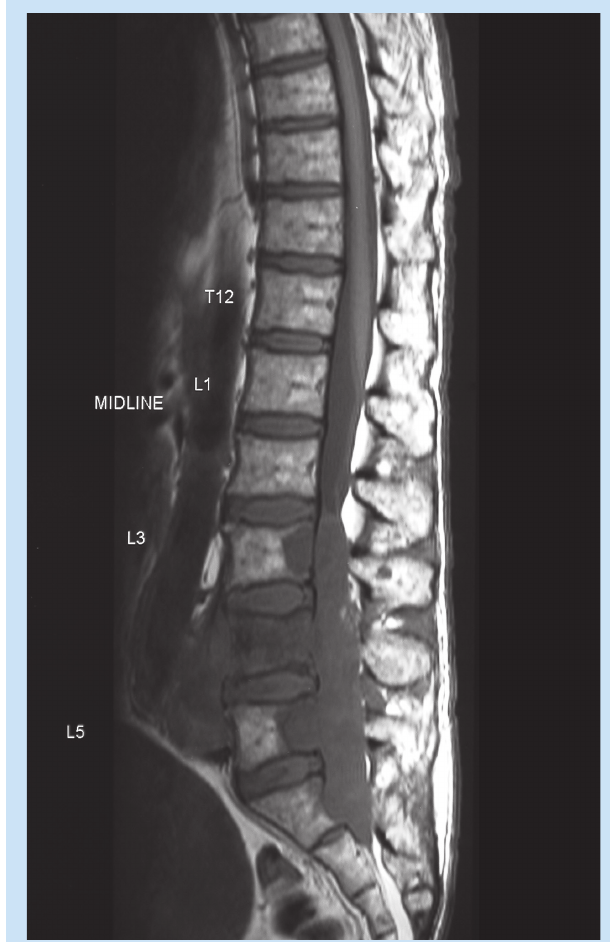
Fig. 1. T1 sagittal. Hypointense lobulated soft-tissue mass located in spinal canal destroying part of L3 and L5 vertebrae with complete destruction of L4 vertebra. There is an additional anterior vertebral component and extension into the sacral part of the spinal